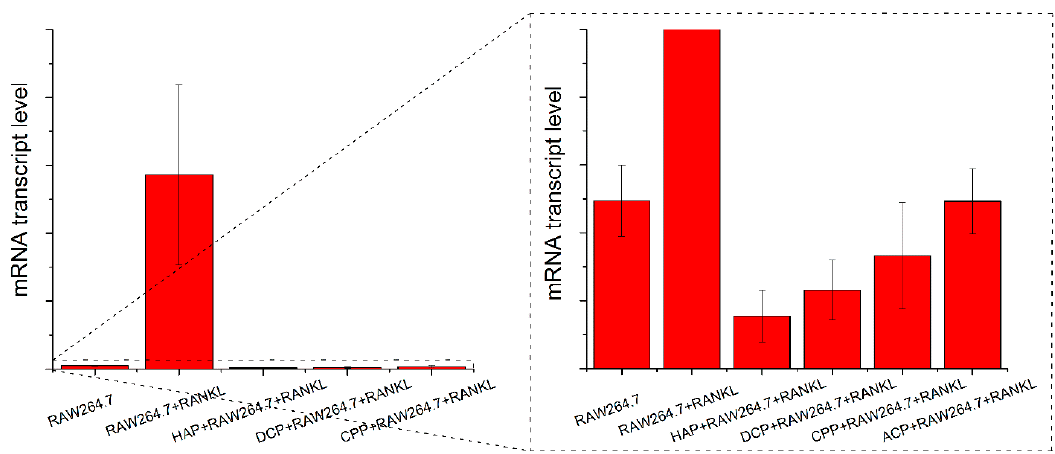
Figure 8. mRNA transcript levels of TRAP as an osteoclastic gene expression marker compared between different cell populations: undifferentiated RAW264.7 cells, RAW264.7 cells differentiated with the use of RANKL, and differentiated RAW264.7 cells subjected to treatments with various types of CAP nanoparticles: hydroxyapatite (HAP), dicalcium phosphate anhydrous (DCP), calcium pyrophosphate (CPP), and amorphous CAP (ACP). Gene expression is normalized to the expression of POLR2A as the housekeeping gene. The magnified region of low mRNA transcript levels is shown to differentiate between the effects of different CAP powders.